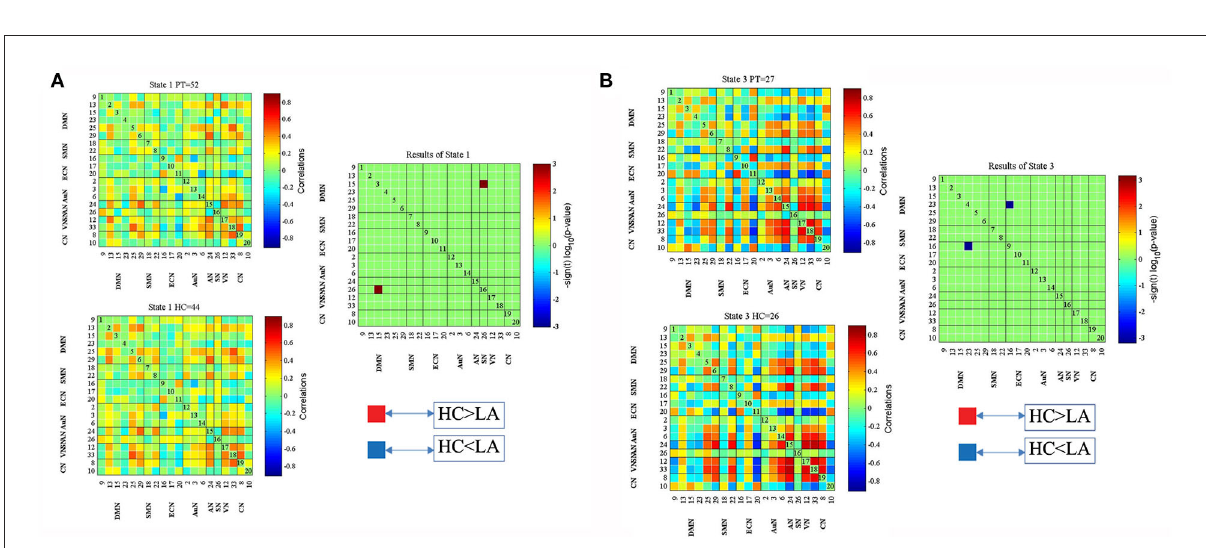
FIGURE3 Significant differences in dFNC between the LA and healthy control (HC) groups in State 1 (A) and State 3 (B) . The top and bottom rows on the left side represent median connectivity matrices in LA and HC, respectively.